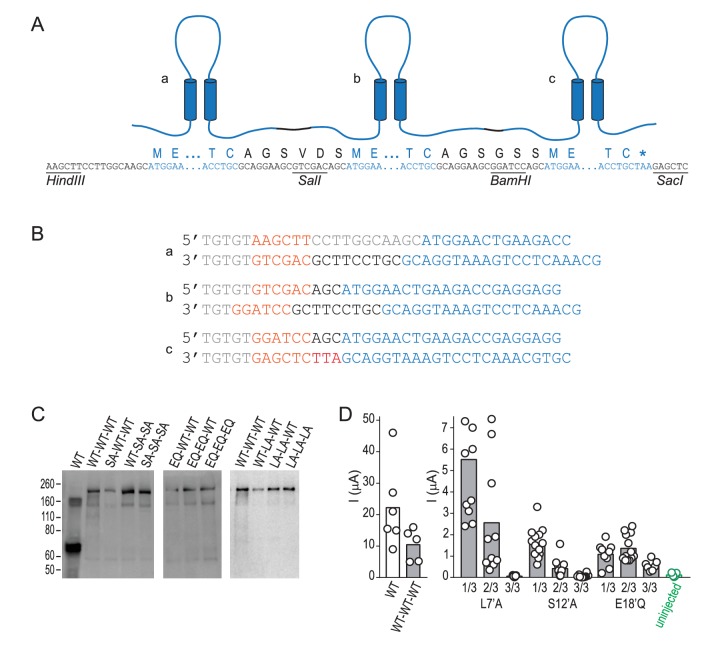
Design and biochemical validation of concatemeric ASICs.(A) Cartoon illustrating three linked subunits, ‘a-c’ in a concatemeric channel. Lettering below shows nucleotide and protein sequence, containing: untranslated nucleotide sequence, restriction sites and peptide linkers (black); and ASIC1a sequence (blue). (B) Primer pairs used to generate fragments a-c for subsequent ligation into concatemeric constructs, including: nucleotide spacers and untranslated sequence (grey); restriction sites (orange); peptide linker (black); and ASIC1a sequence (blue). (C) Western blot, detecting ASIC1a amongst denatured total cell-surface protein from oocytes injected with indicated ASIC1a mRNAs. ‘WT’, regular ASIC1a; ‘WT-WT-WT’, concatenated wild-type subunits; ‘SA-WT-WT’, one of the three 1/3 S12’A concatemeric permutations tested (shown in Figure 4D), etc. The main band of protein from oocytes injected with regular ASIC1a mRNA is ~70 kDa, corresponding to single ASIC1a subunits. For protein from oocytes injected with concatemeric ASIC1a mRNA, the main band is ~210 kDa, corresponding to three covalently linked subunits in a concatemer. (D) Maximum current amplitude (‘I (μA)”) activated by pH 5.0 at oocytes injected with regular WT ASIC1a mRNA (‘WT’), concatemeric WT mRNA (‘WT-WT-WT’), concatemeric mutant mRNA, or nothing (‘uninjected’). Columns, mean current amplitude; circles, individual data points. Current amplitude at 3/3 L7’A-mutant and at 3/3 S12’A-mutant-injected oocytes was not discernable from uninjected oocyte.